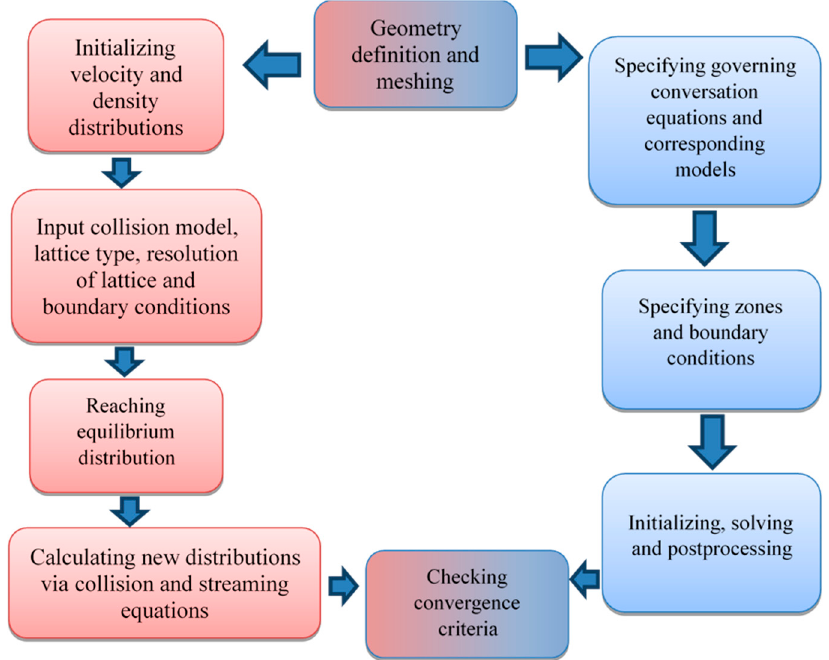
Figure 3. Conventional computational fluid dynamics (CFD) methods versus lattice Boltzmann methods (LBM) algorithms.